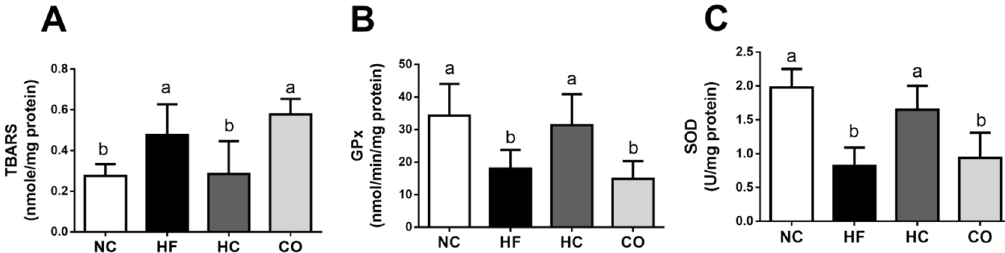
Figure 4. The changes in hepatic thiobarbituric acid reactive substances (TBARS) levels ( A ) and antioxidative enzymes (glutathione peroxidase (GPx) ( B ) and superoxide dismutase (SOD) ( C ) activities in rats fed with different experimental diets for 12 weeks. Data are expressed as the mean ± S.D. for each group ( n = 8). Values with different superscript letters (a, b) are significantly different from each other ( p < 0.05). NC: Normal control diet (chow diet). HF: High-fat diet (chow diet + 10% lard). HC: HF diet + 5% high-molecular-weight chitosan. CO: HF diet + 5% chitosan oligosaccharides.